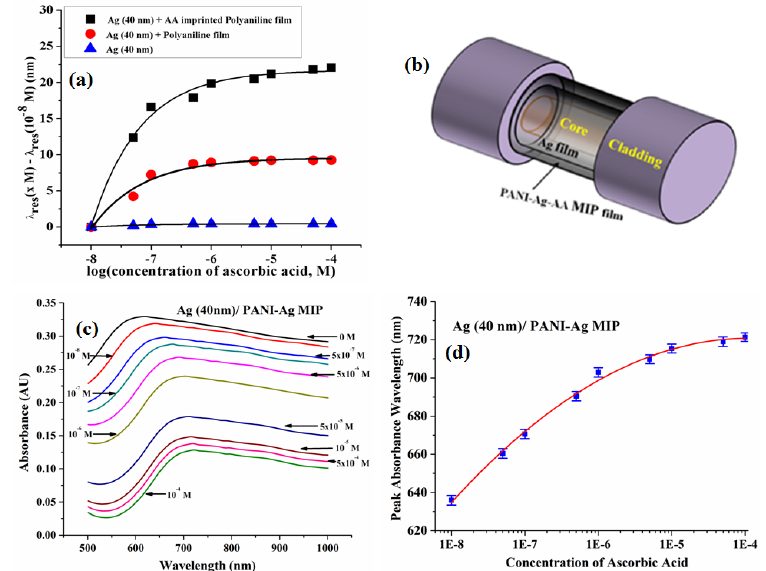
Figure 14. ( a ) Comparison of MIP, NIP and simple Ag film-based SPR sensor in terms of shift in resonance wavelength with varying concentration of ascorbic acid from 10 − 8 –10 − 4 M. Reprinted with permission from [166]. Copyright 2015 Springer; ( b ) Schematic diagram of the FO-LSPR + SPR-based PANI-Ag MIP probe; ( c ) the absorbance spectra and ( d ) shift in peak absorbance wavelength for the corresponding probe. Reprinted with permission from [66] Copyright 2016 Institute of Physics .